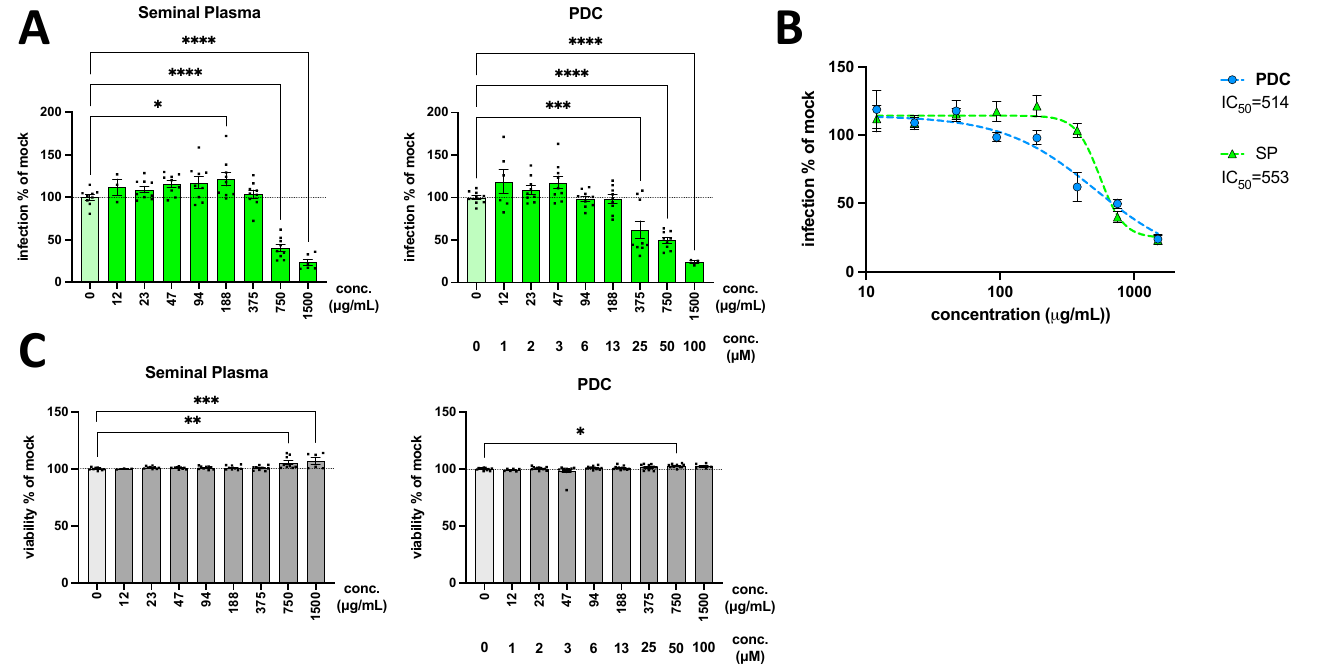
Figure 5. Activity of PDC-109 and SP against VSVg pseudotype infections. VeroE6 cells were pre- treated for 15 min with SP or PDC-109, respectively. Then, cells were spin-infected in presence of both reagents for 30 min, followed by 90 min incubation at 37 ◦ C. Subsequently, cells were washed and cultured for another 24 h. ( A ) The frequency of GFP+ VeroE6 cells, reflecting the extent of infectivity, was assessed for SP and PDC-109 (PDC) based on flow cytometry measurements. Data were normalized to mock-treated control infections. Bars show mean with SEM. Significance was assessed by parametric one-way analysis of variance (ANOVA) tests, comparing all samples with the mock control (0 µ M) and displayed as follows: **** p < 0.0001; *** p < 0.001; ** p =